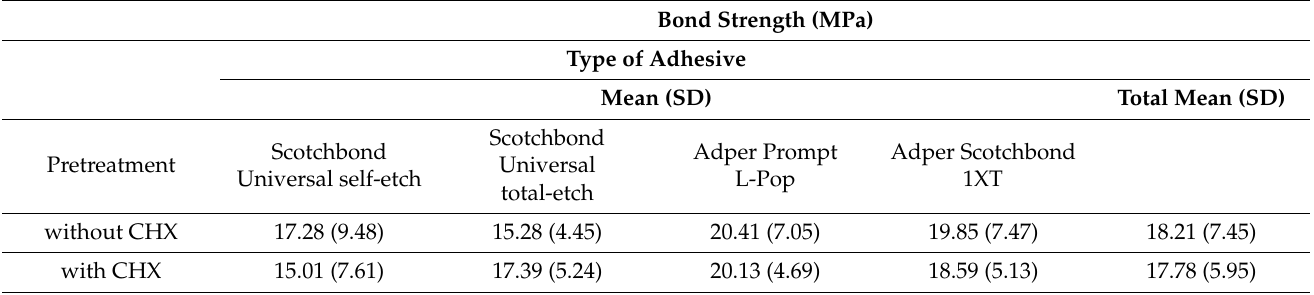
Table 3. BS descriptive analysis depending on the type of adhesive and